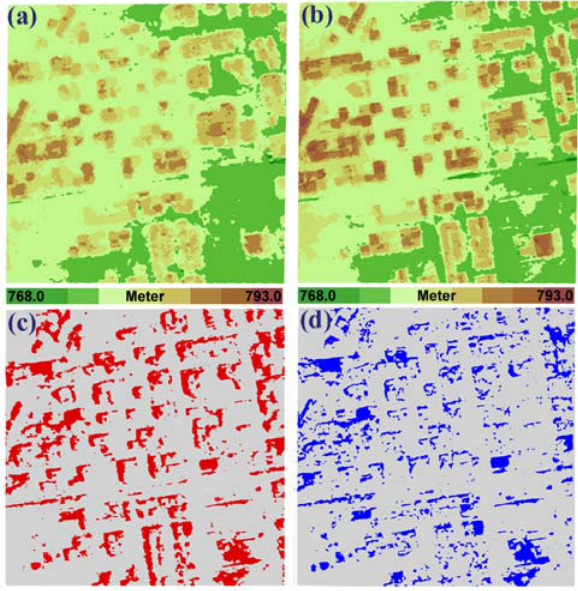
Figure 2. (a) IKONOS DSM, (b) GeoEye DSM, (c) and (d) binary change maps with D-DSMs larger than 2.5m: (c) before (red), and (d) after (blue) shift elimination After shift elimination, the differences in height were computed for each position in object space, see equation Figure 1. Sample of building changes (a) and (c): GeoEye 2009, (b) and (d): IKONOS 2008